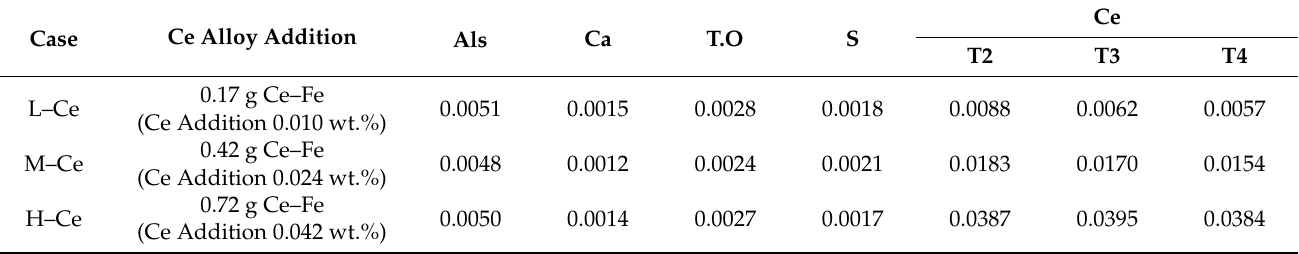
Figure 3. Schematic diagram of the processing of the molten steel sample. Table 2. Amount of Ce added to the oil casing steel and the chemical composition of the sample, wt.%.